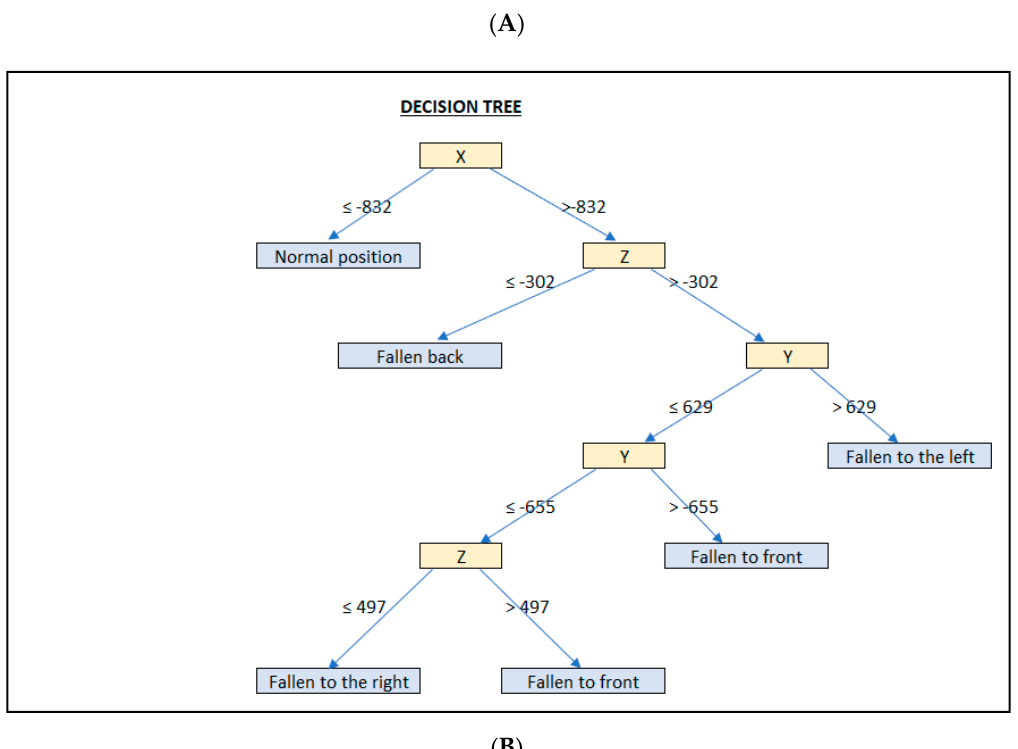
Figure 9. Descriptive model ( A ) and the decision tree produced by algorithm J48 ( B ). To measure the accuracy of the model obtained, we can consider the statistical data obtained on the values of the training sample, whose separation between test and training